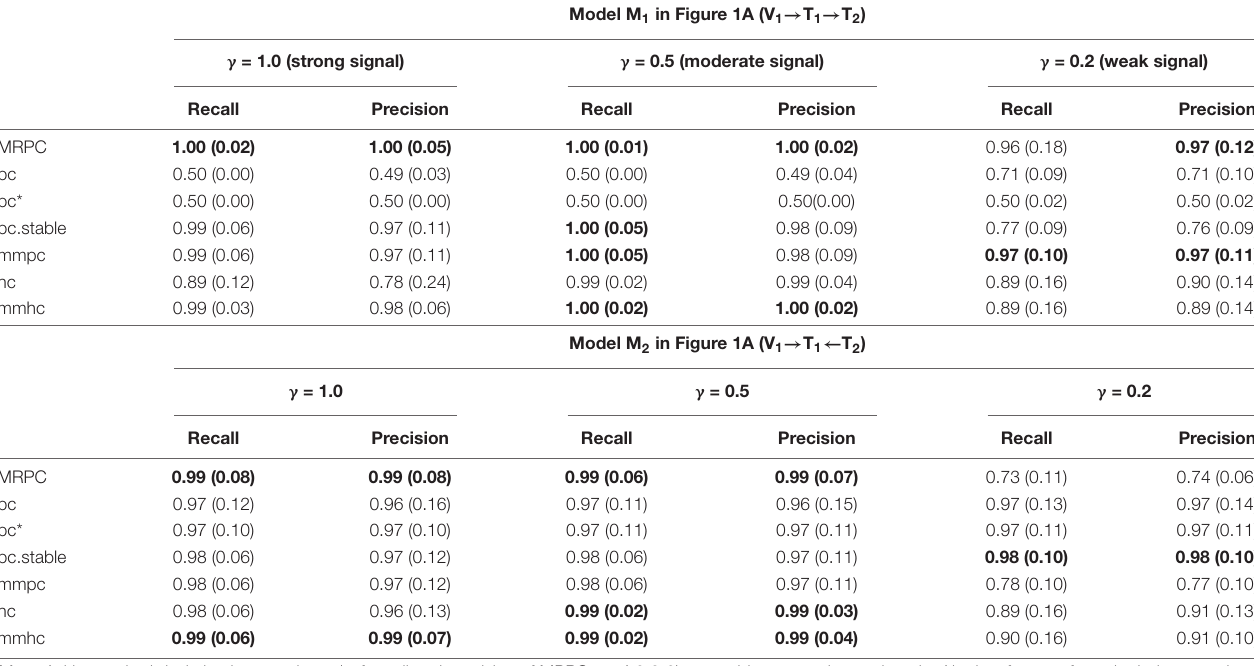
TABLE 1 | Comparison of inference accuracy without and with a